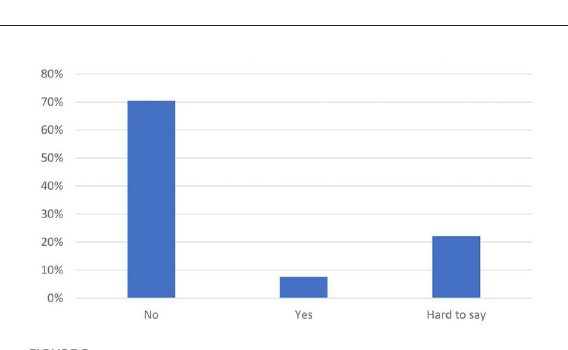
FIGURE5 Have you been appreciated by the society? ( N =